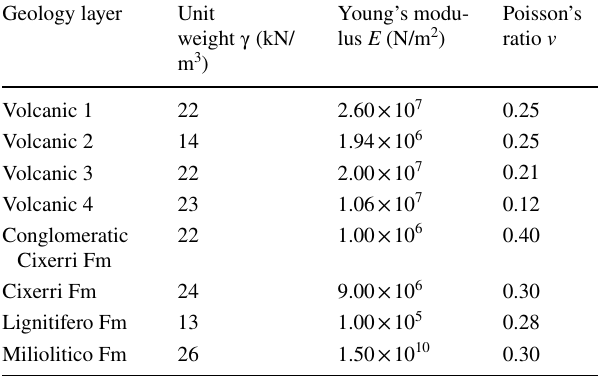
Table 1 Geotechnical parameters used for modeling. The volcano- pyroclastic rocks and ignimbrites are named Volcanic 1 to 4. The Cixerri Fm. is subdivided into two patterns. Retrieved from